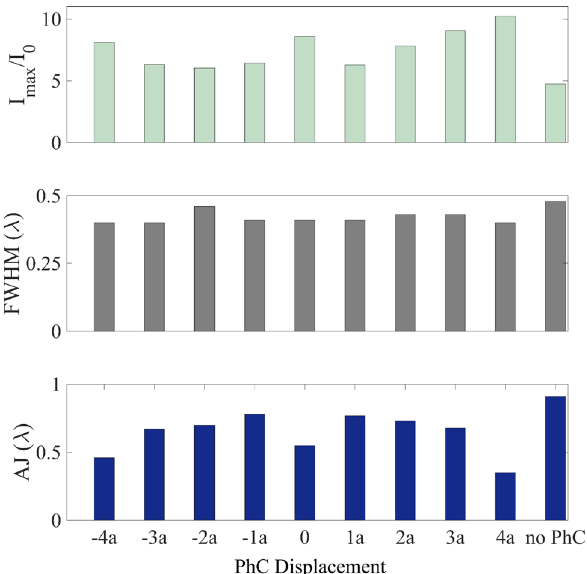
Figure 3. Acoustic parameter comparative for different PhC displacements inside the ABS cylinder.